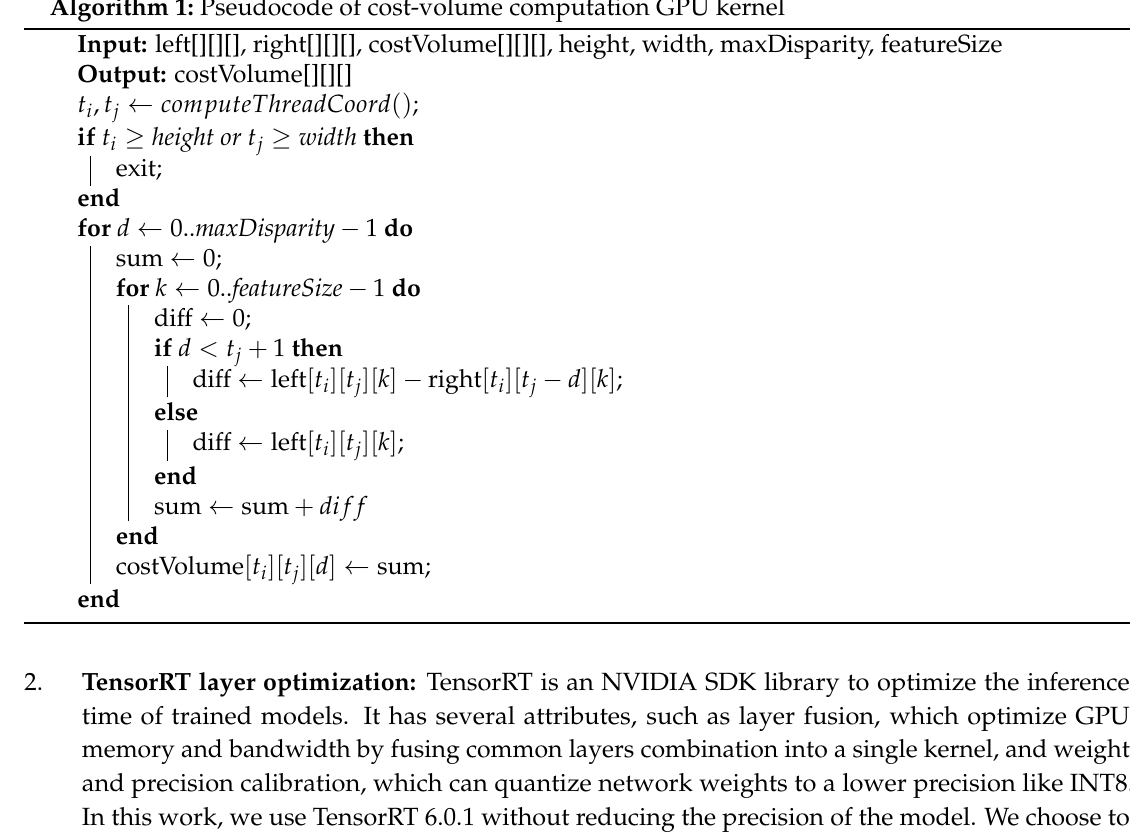
Algorithm 1: Pseudocode of cost-volume computation GPU kernel